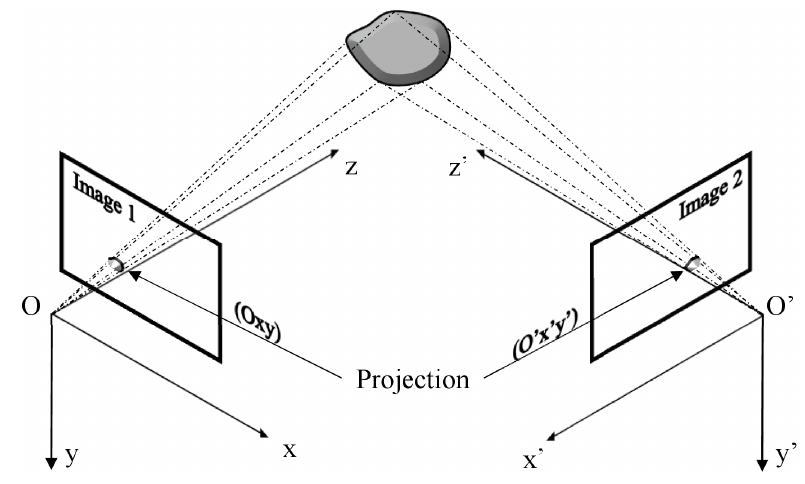
Figure 3. Measurement principle.